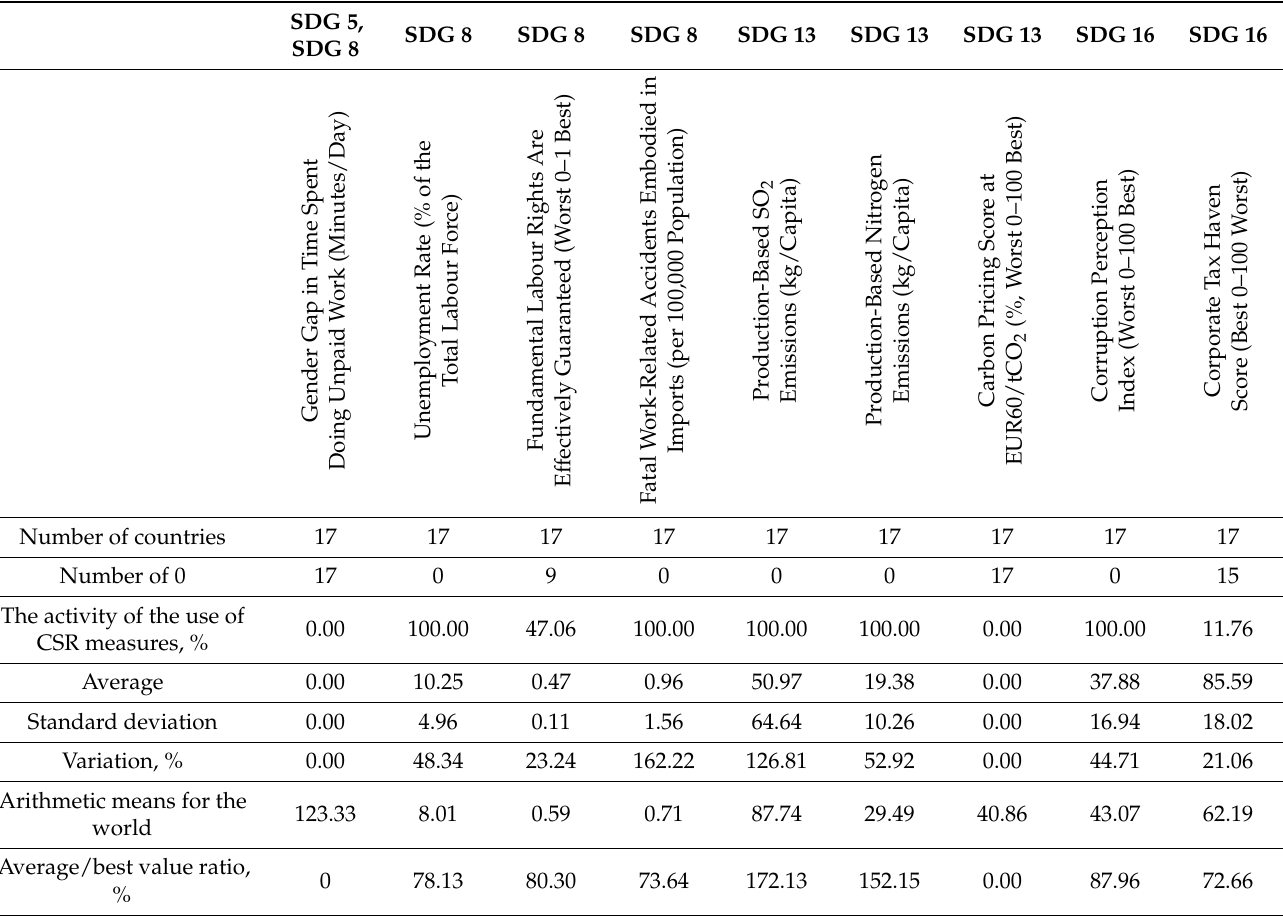
Table 8. Representation of the CSR practices to support the SDGs (UN standards) in countries of MENA in